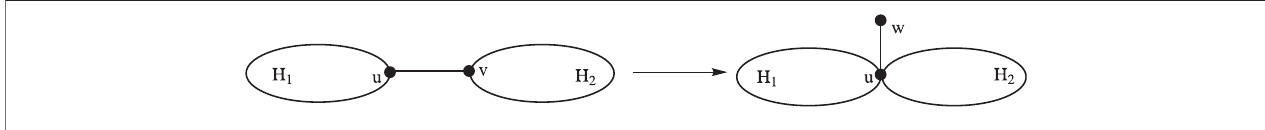
FIGURE 2 | Graphs G 1 and G 2 of Lemma